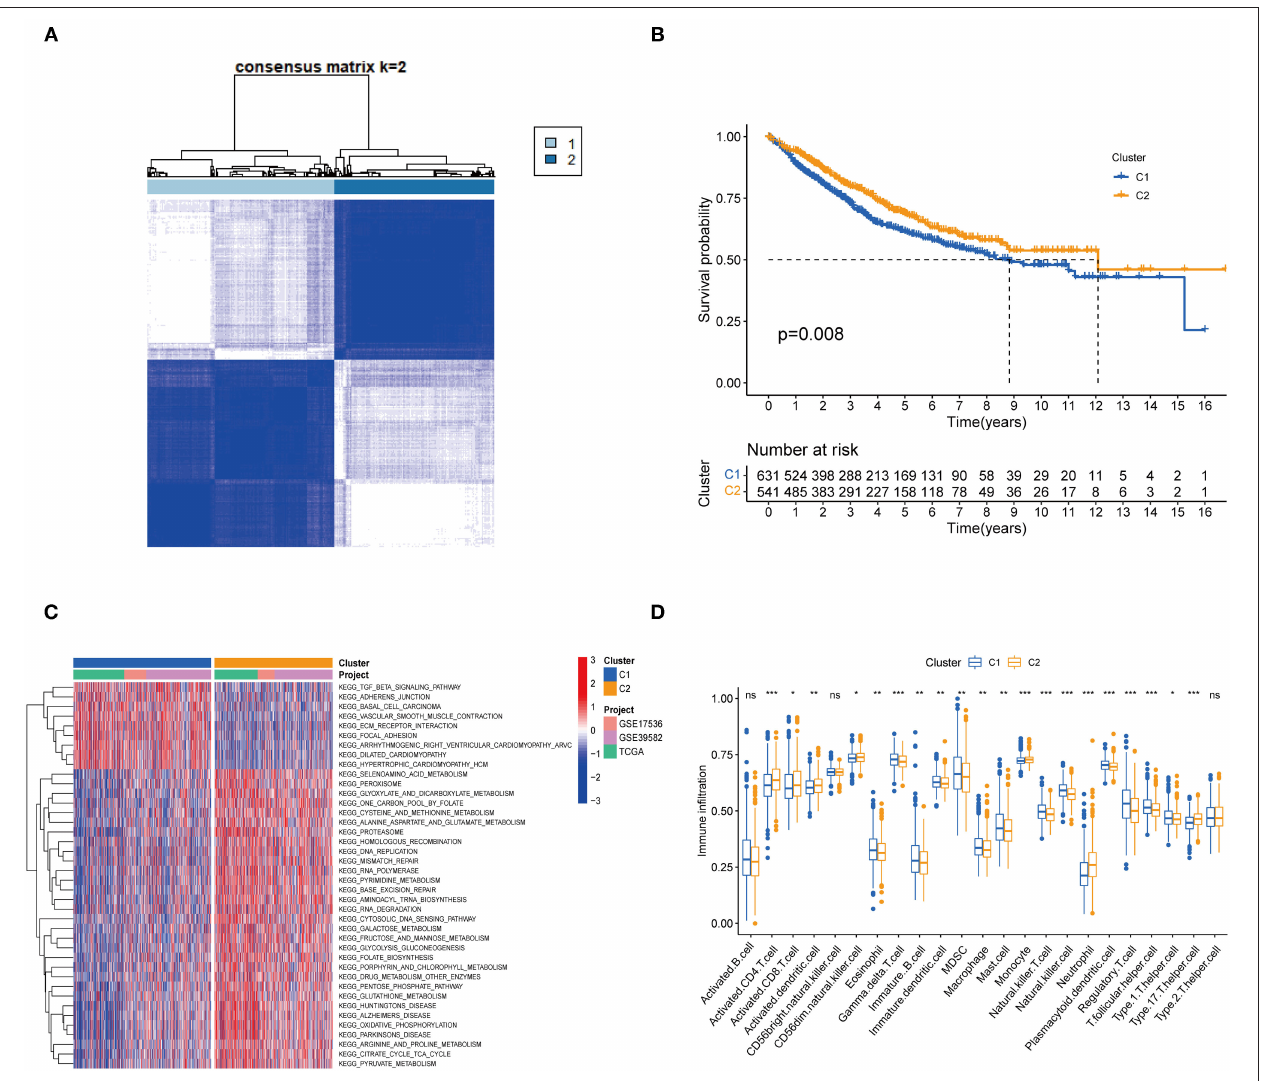
FIGURE 2 | Subgroups of colon cancer related by necroptosis-related regulators. (A) Consensus clustering of colon patients for k = 2 in the meta-cohort (GSE39582, GSE17536 and TCGA-CORD). (B) Kaplan-Meier curves (Log-rank test, P = 0.008) for overall survival (OS) of two necroptosis-related molecular subtypes. (C) GSVA enrichment analysis showed the activation status of biological pathways in two necroptosis-related molecular subtypes. Red: activation of biological pathways, blue: inhibition of biological pathways. (D) ssGSEA analysis showed the difference in the abundance of TME-infiltrated cells between the two subtypes (* P < 0.05; ** P < 0.01; *** P < 0.001; ns, not statistically